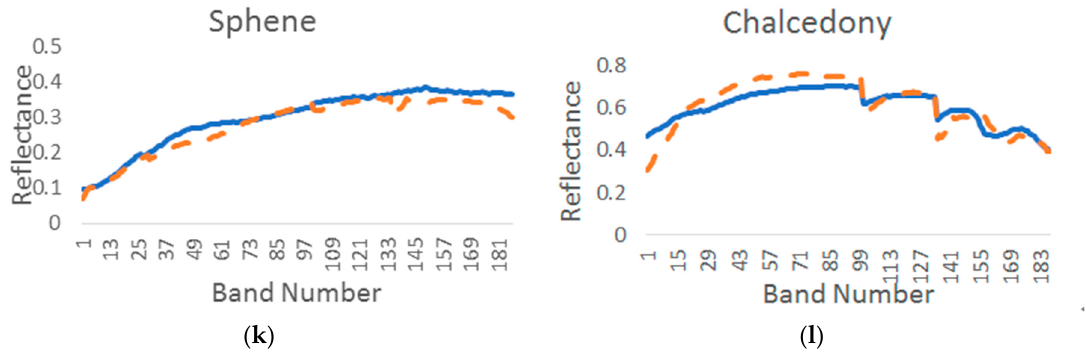
Figure 17. Results on the AVIRIS Cuprite image: Comparison of the USGS library spectra (solid line) with the endmember spectra extracted by PISINMF (dotted line). ( a ) Alunite; ( b ) Andradite; ( c ) Buddingtonite; ( d ) Dumortierite; ( e ) Kaolinite_1; ( f ) Kaolinite_2; ( g ) Muscovite; ( h ) Montmorillonite; ( i ) Nontronite; ( j )Pyrope; ( k ) Sphene; ( l ) Chalcedony. Table 10. SAD results on the AVIRIS Cuprite